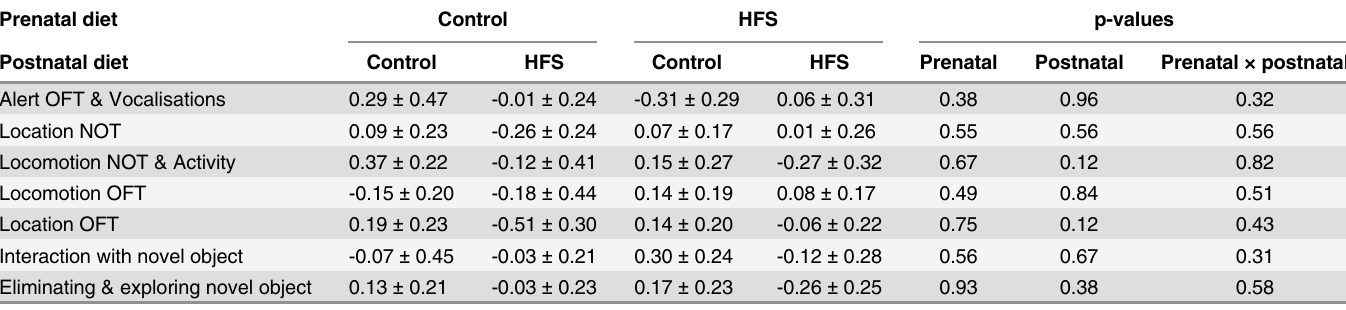
Table 6. Behavioural responses of piglets in the open field and novel object tests expressed as factor scores extracted by principal component analysis. Prenatal